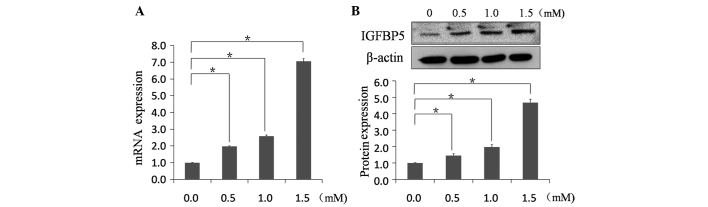
The mRNA and protein expression of IGFBP5 increases in a dose-dependent manner in NRVMs treated with MA for 48 h. NRVMs were incubated with MA at varying concentrations (0, 0.5, 1.0 or 1.5 mM). (A) Total RNA was subjected to reverse transcription polymerase chain reaction. (B) Whole cell lysates were analyzed by western blotting. An antibody against β-actin was used as the loading control. The data are presented as the mean ± standard deviation (n=6; *P<0.01). MA, methamphetamine; NRVMs, neonatal rat ventricular myocytes; IGFBP5, insulin-like growth factor binding protein-5.